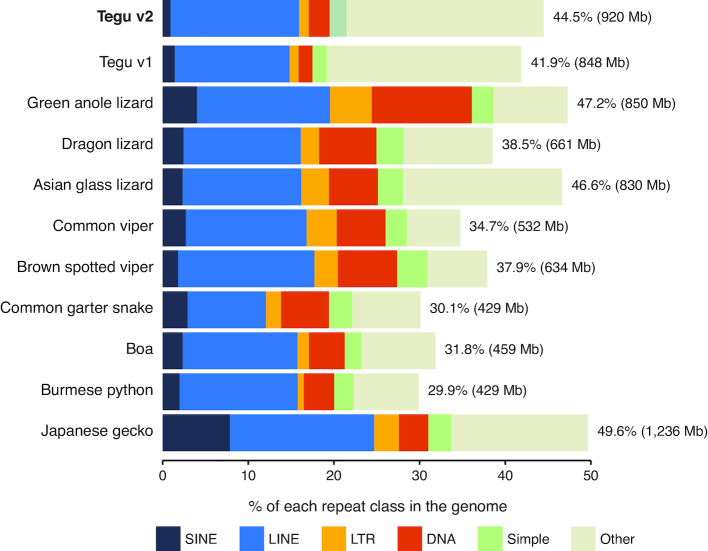
Repeat landscape in squamate genomes. Major classes of repeats are color coded and shown as bar charts that represent the portion of the genome they cover. Simple repeats comprise tandem repeats, low complexity regions, and satellite repeats.